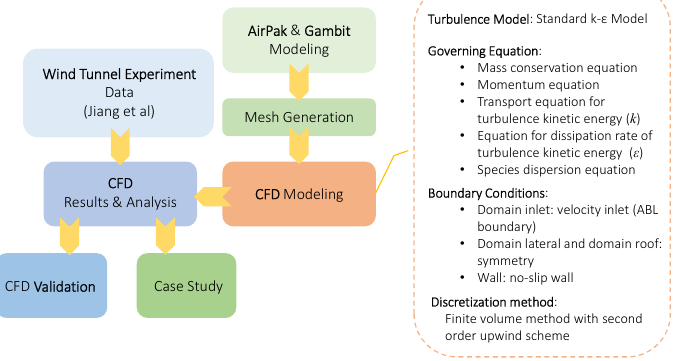
Figure 1. Computational Fluid Dynamic ( CFD) modeling flowchart.